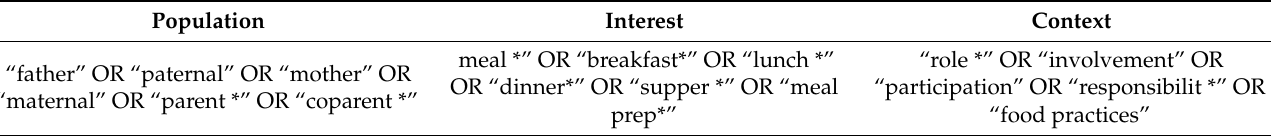
Table 1. Search terms aligned with PICO framework. Population Interest Context “role *” OR “involvement” meal *” OR “breakfast*” OR “lunch *” OR “dinner*” OR “supper *” OR “meal prep*”